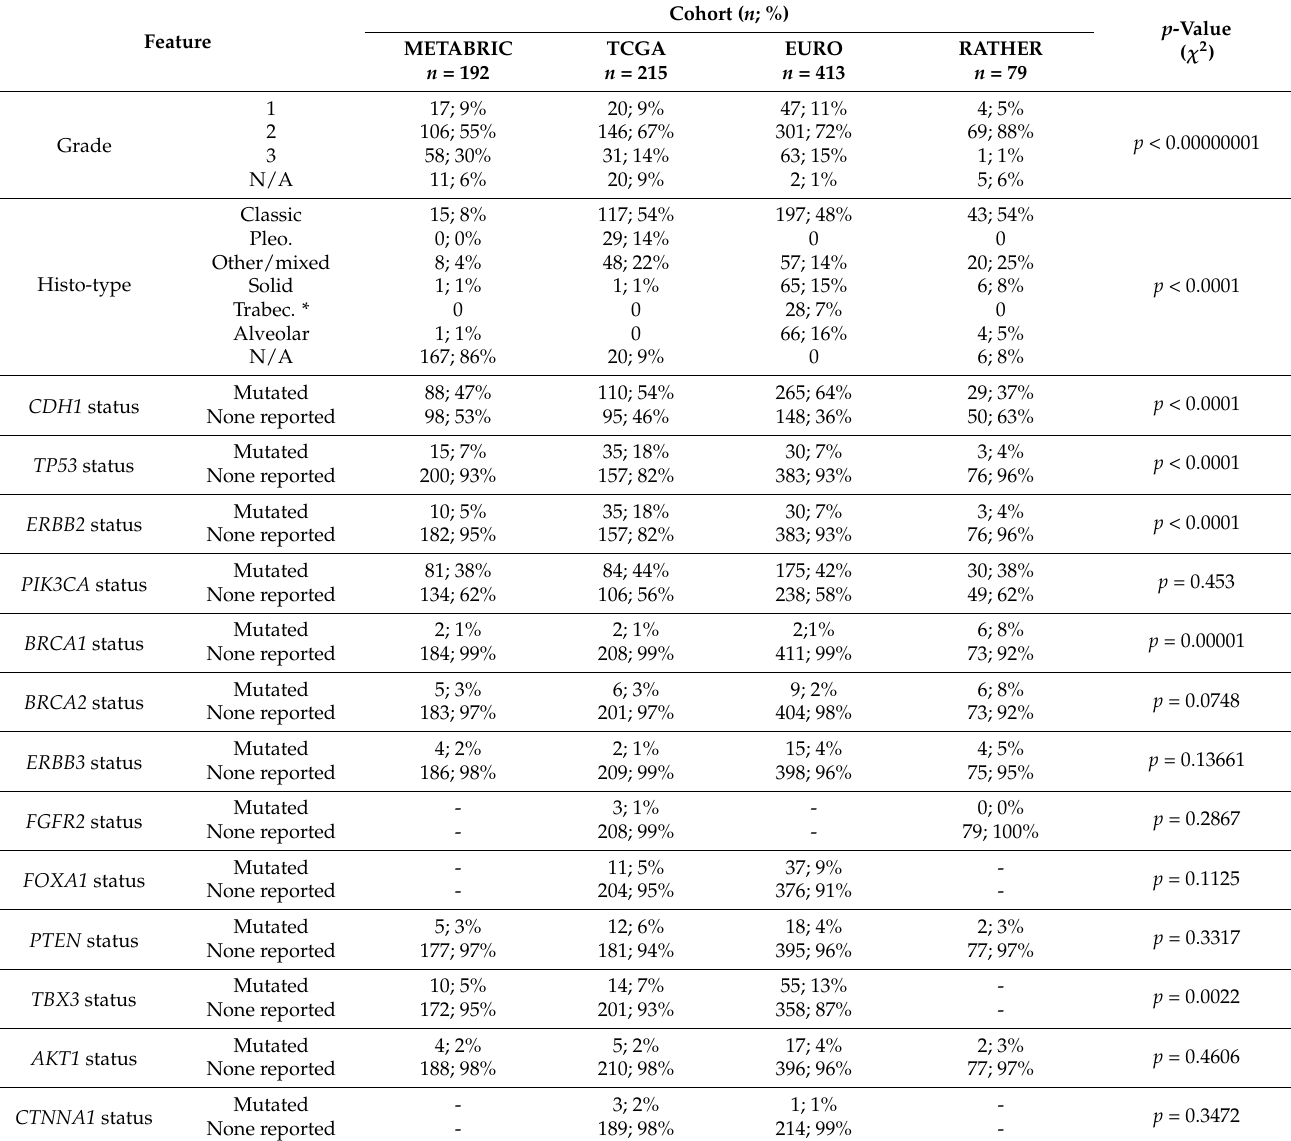
Table 1. Relationships between invasive lobular carcinoma (ILC) pathology and molecular features across 4